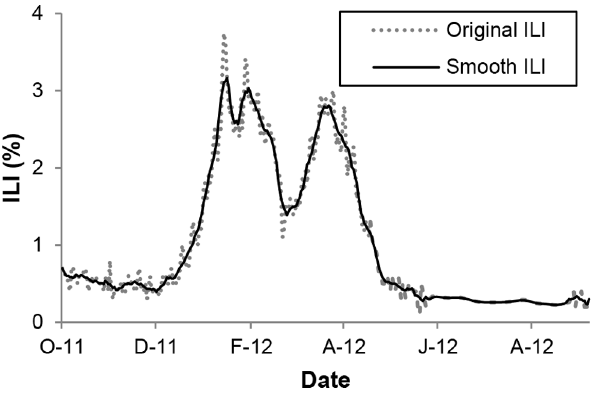
Figure 2. Comparison of original and smoothed ILI data by KCDC. The data were observed between October 2011 and September 2012.